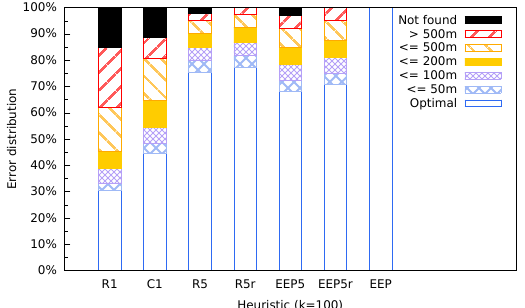
Figure 5: Error distribution of retrieved routes averaged over all scenarios using k = 100.